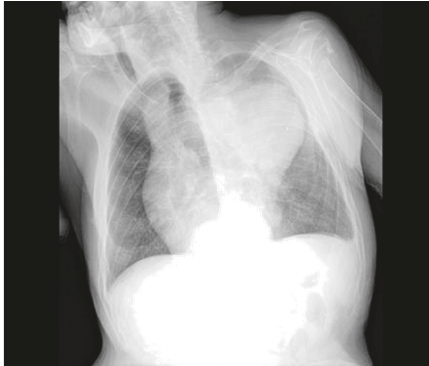
Figure 3: Aortic aneurysm with extravasation blood on lung parenchyma.